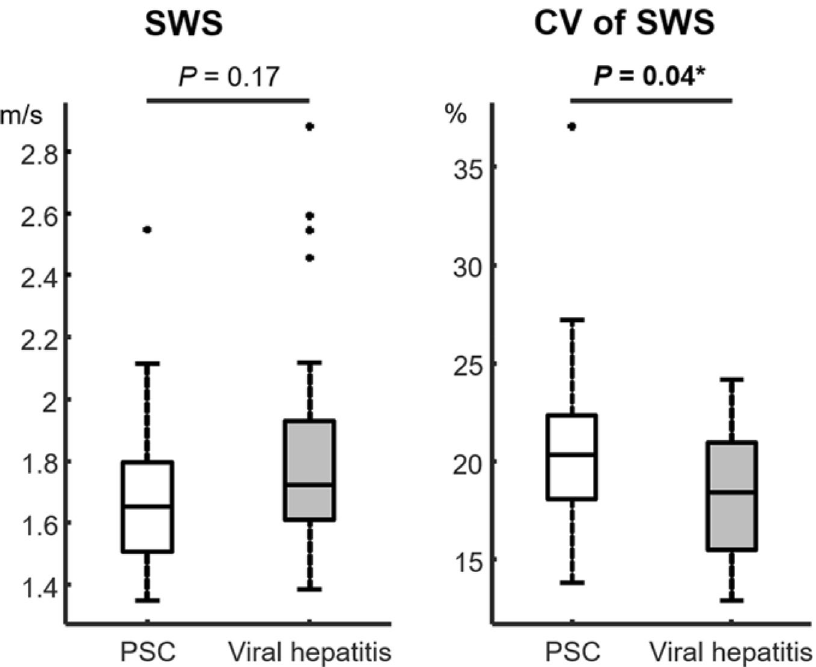
Figure 3. Boxplots display median, upper and lower quartiles, and whiskers of shear-wave speed (SWS) and coefficient of variation (CV). Statistically significant differences are indicated by an asterisk (*) for P < 0.05. PSC primary sclerosing cholangitis